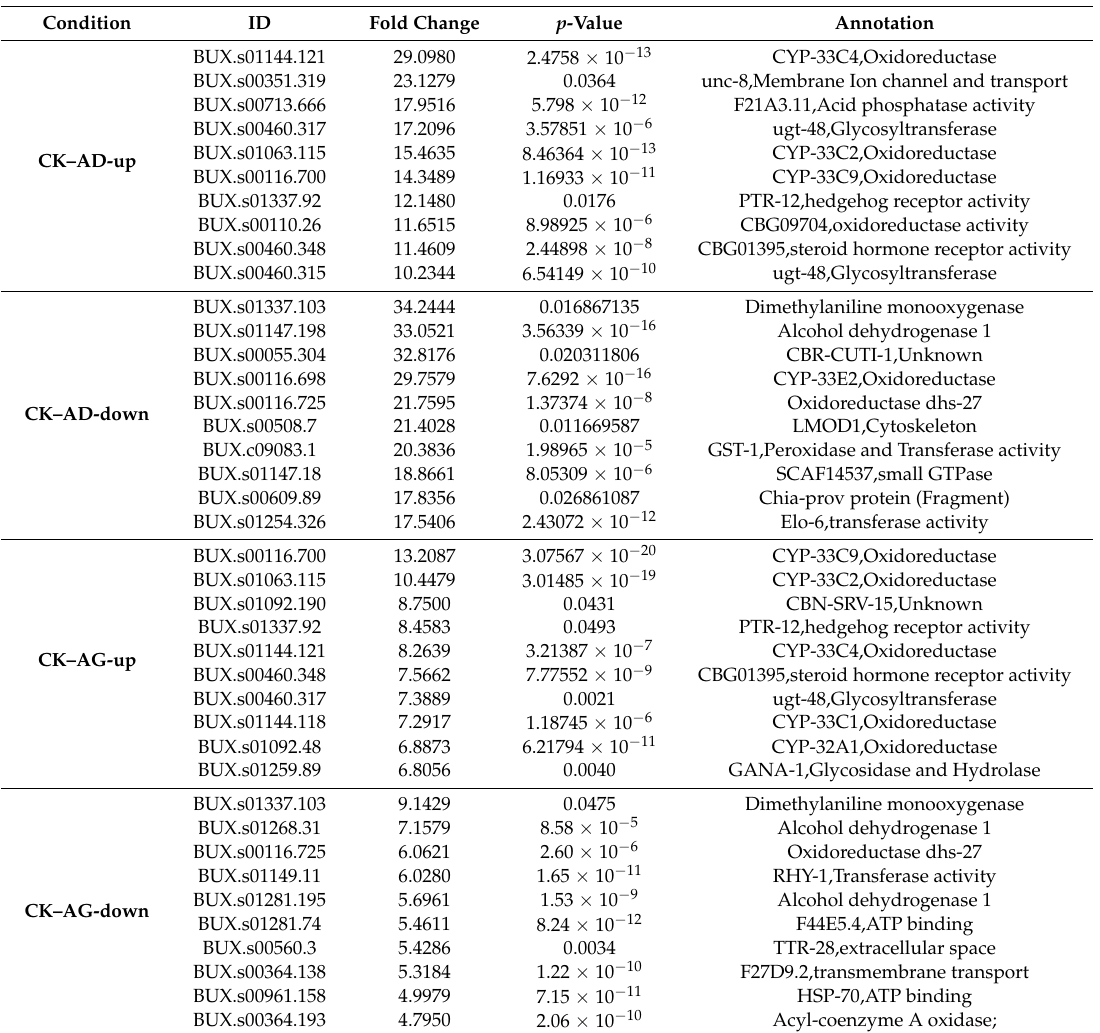
Table 2. Upregulated and downregulated Bursaphelenchus xylophilus genes induced by α